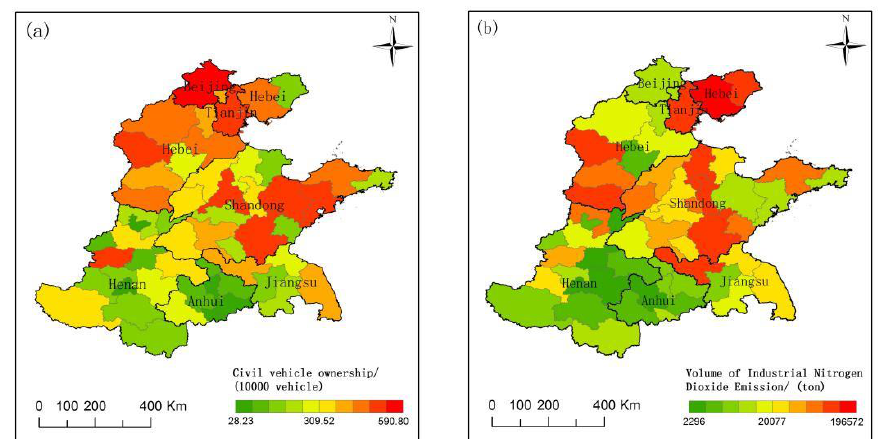
Figure 5. ( a ) Spatial distribution of civil vehicle ownership in the NCP in 2019; ( b ) Spatial distribution of industrial NOx emissions in the NCP in 2017.